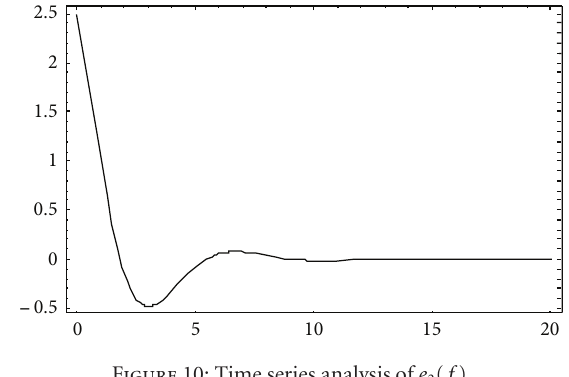
Figure 7: Phase plot of slave system.